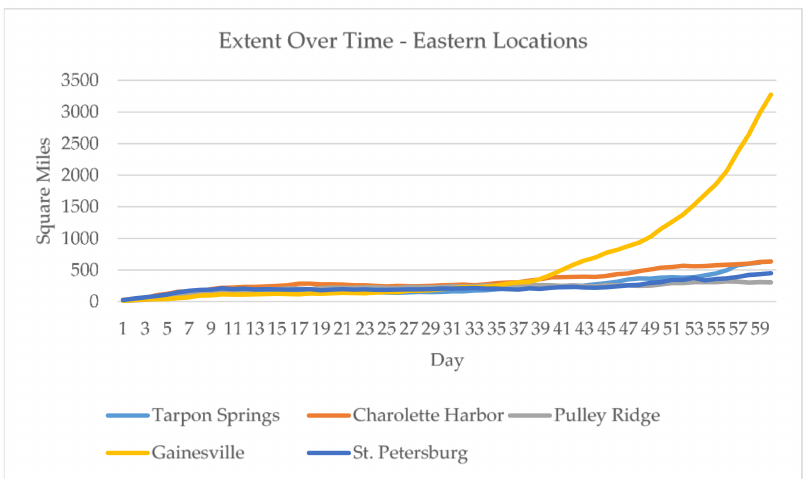
Figure 2. Plume extent as a function of time for the eastern